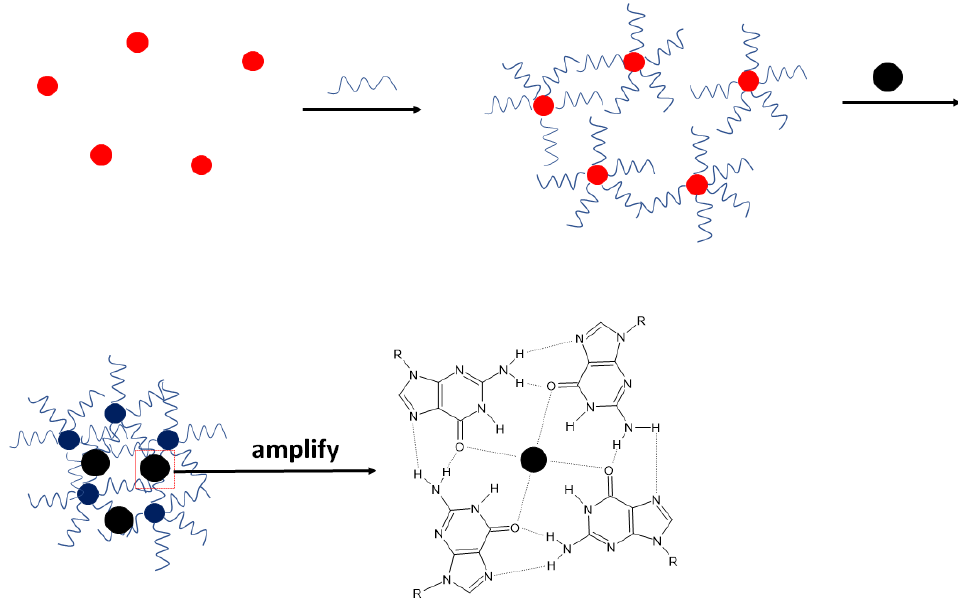
Figure 3. The sensing principle scheme of the optical aptasensor for potassium ion with gold nanoparticles with the use of their aggregation phenomena.